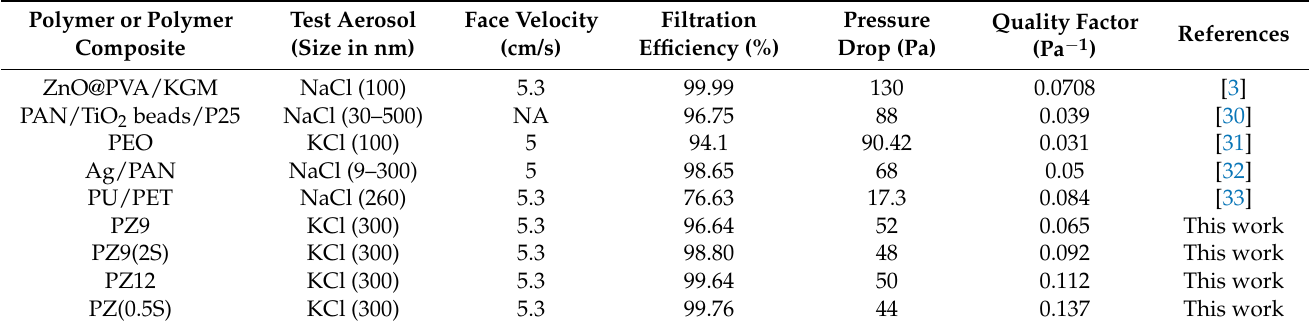
Figure 8. Filtration efficiencies and pressure drops of ( a ) PZ9-based filters and ( b ) PZ12-based filters. Table 5. Pressure drop, filtration efficiency, and quality factor values for the as-prepared and previously reported nanofiber